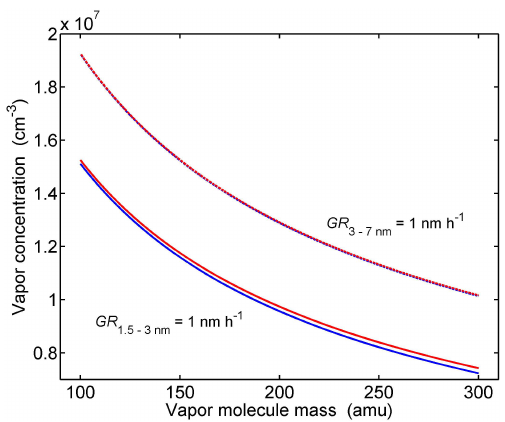
Fig. 1. The required vapor concentration for growth rate 1nmh − 1 over particle size range 1.5–3nm (solid lines) and 3–7nm (dashed lines). The particle density and vapor liquid phase density are both assumed to be 1.83 g cm − 3 (liquid phase density of sulphuric acid). Result using approximation of Eq. (8) is shown in red and result by numerically integrating Eq. (5) is shown in